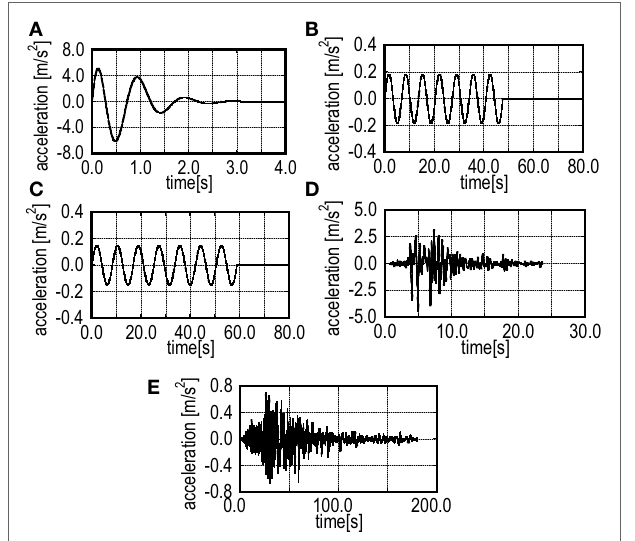
FIGURE 6 | Input ground motions: (A) artificial pulse-type ground motion ( T p = 1.0s), (B) artificial long-period, long-duration ground motion (6.8s), (C) artificial long-period, long-duration ground motion (8.4s), (D) JMA Kobe NS (level 2: 0.5m/s), and (E) Tomakomai EW (2003) .